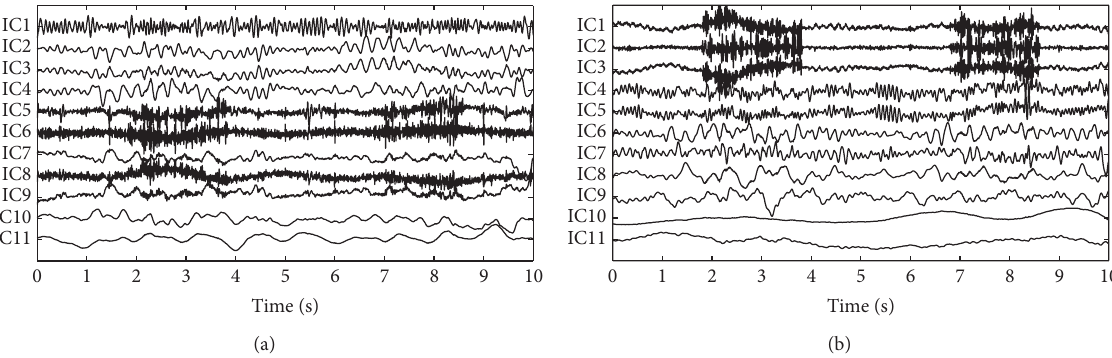
Figure 7: The components decomposed by using EEMD-ICA to the synthetic data at two different SNR values: (a) SCICA at 𝜀 = 0.4 (SNR = 3.80) and (b) SCICA at 𝜀 = 2 (SNR =